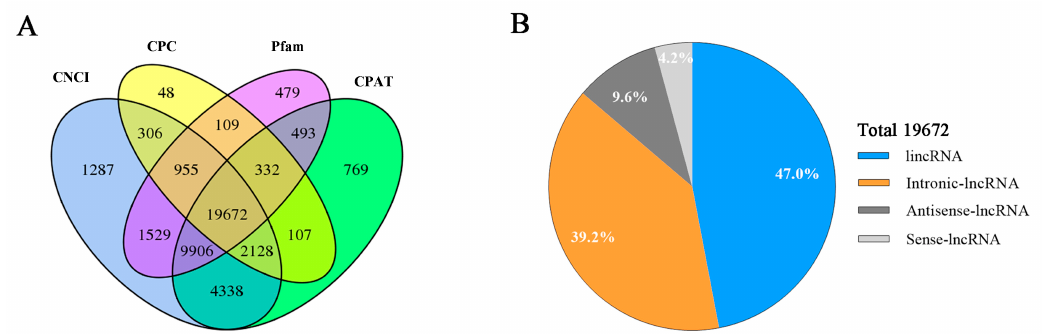
Figure 1. Identification of lncRNAs. ( A ) The lncRNAs were identified from the intersection of CNCI, CPC, Pfam and CPAT. ( B ) Classification of 19,672 lncRNAs, including LincRNAs, Intronic-lncRNAs, Antisense-lncRNAs and Sense-lncRNAs.